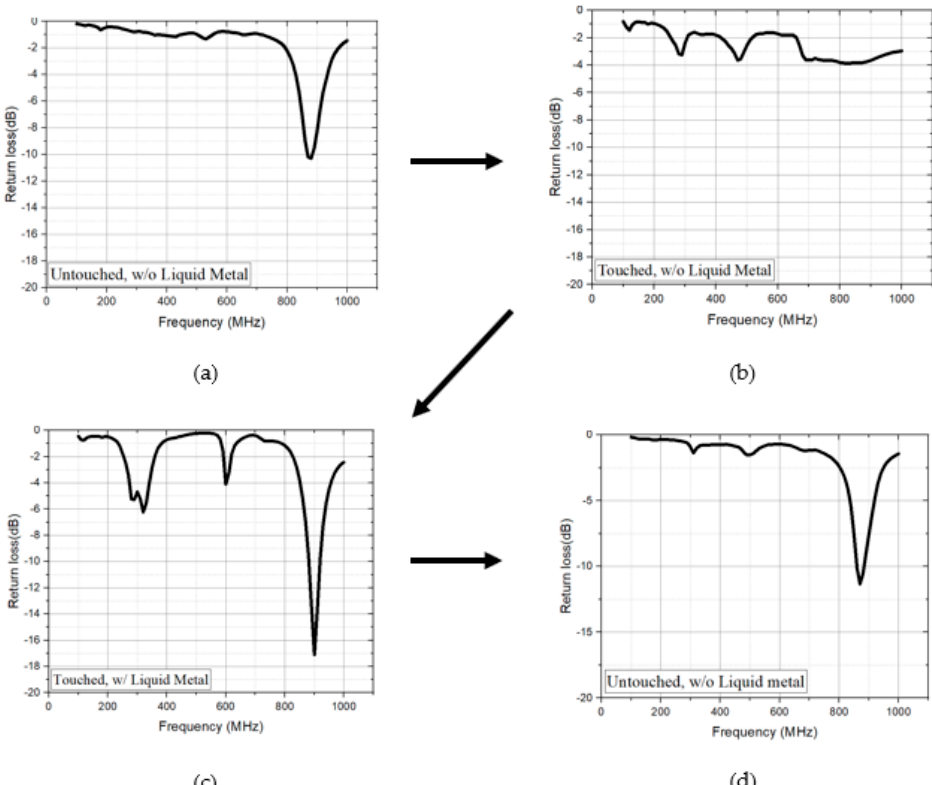
Figure 7. Measurement results of the full prototype with the PIFA and microfluidic tuner in the mockup: ( a ) not touched mockup, and not injecting liquid metal alloy; ( b ) touched mockup, and not injecting liquid metal alloy; ( c ) touched mockup, and injecting liquid metal alloy; and, ( d ) not touched mockup, and extracting liquid metal alloy.